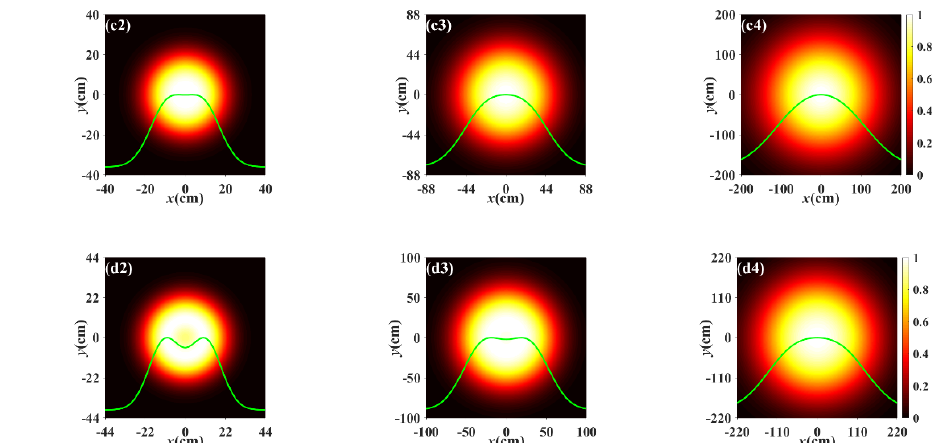
Figure 3. Normalized spectral intensity distribution of the PCTLGP beam at several propagation distances in anisotropic turbulence for different mode orders and topological charges ( ξ x = ξ y = 3, C ̃ 2